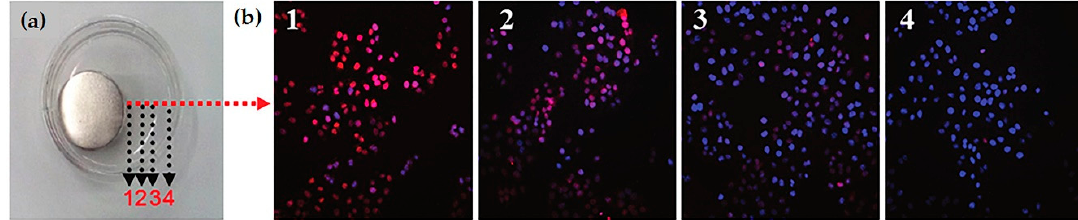
Figure 20. Photography of the experimental setup ( a ) and respective confocal images of MCF-7 cells ( b ) after 12 h of incubation with the systems based on magnetic MSNs, where B1 is the image closest to the magnet and B4 is the farthest one. Nuclei were stained with DAPI (blue color) and systems contain doxorubicin with fluorescence properties (red color). Reproduced from [124], with permission from The Royal Society of Chemistry.